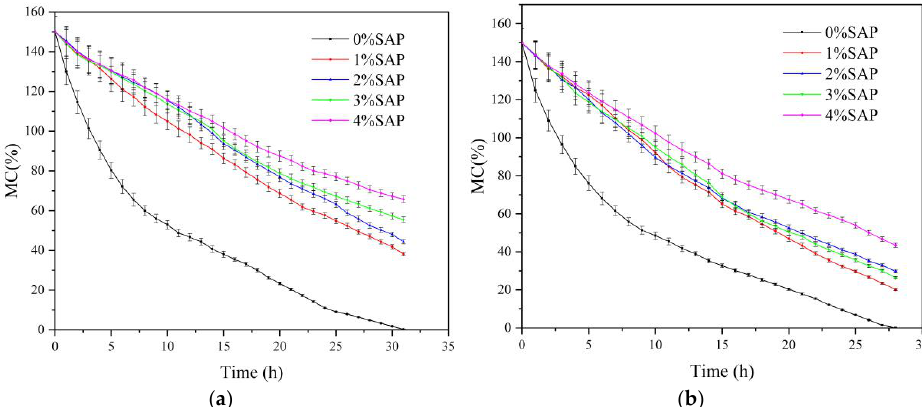
Figure 8. ( a ) Water retention of SW-AA-AM polymer in soil. ( b ) Water retention of SW-AA-AM polymer in coal.